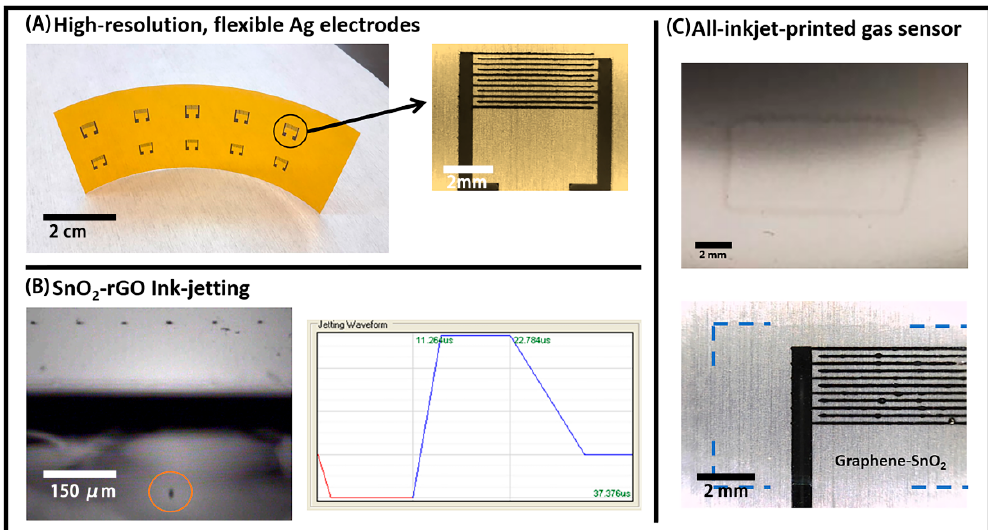
Figure 5. ( A ) Inkjet-printed Ag Interdigitated electrode structures (IDEs) arrays on Kapton; ( B ) successful jetting of a single droplet of the SnO 2 -rGO dispersion in NMP (left) and the respective waveform used for that (right); ( C ) 1-layer inkjet-printed film of SnO 2 -rGO on bare poly(ethylene theraphthalate) (PET) (top) and 2-layers inkjet film of SnO 2 -rGO on Ag IDEs (bottom). Blue traced lines are included to guide the eyes on the last picture, due to the low contrast in the optical microscopy image.